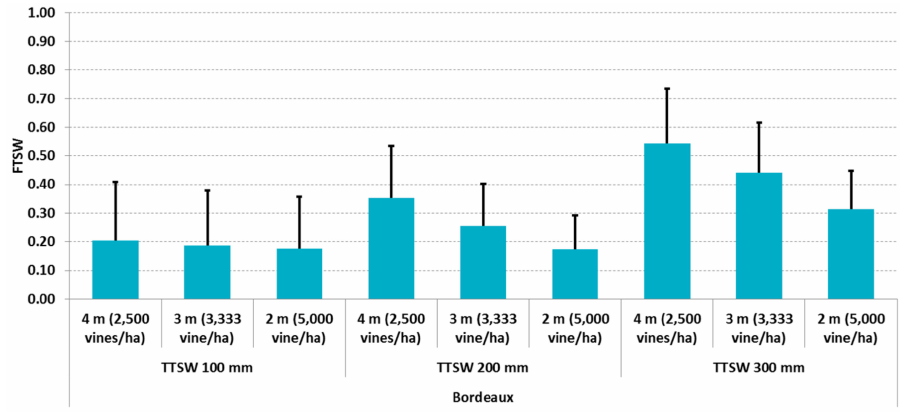
Figure 10. Modelled average fraction of transpirable soil water (FTSW) during 30 days prior to modelled harvest dates for three vines spacings (2, 3, and 4 m) and three levels of total transpirable soil water (100, 200, and 300 mm). Input weather data from 1981–2010, Bordeaux M é rignac weather